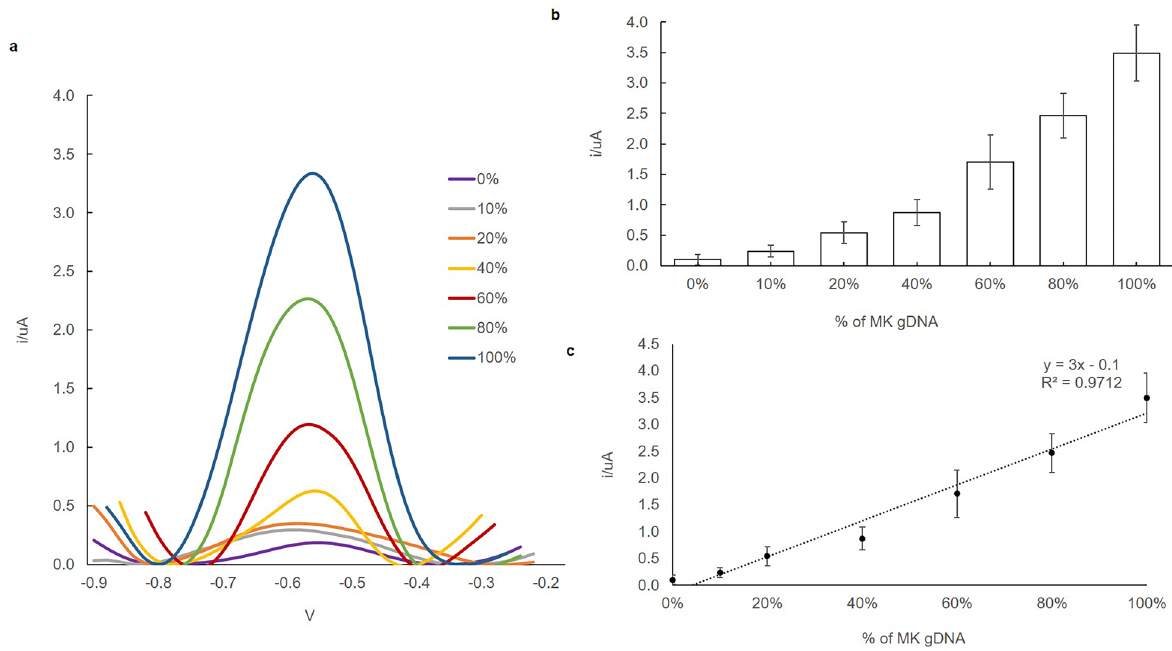
Figure 4. Differential pulse voltammograms ( a ) biosensor response trends; ( b ) linear response range and ( c ) of DNA probe/AuNPs/SPE electrode upon hybridisation with different concentration of MK (0%, 10%, 20%, 40%, 60%, 80%, 100%). Hybridization was performed in 0.05 M K-phosphate buffer (pH 7.0) containing 10 mM AQMS. The DPV peak rate was observed at − 0.55 to − 0.45 V/s versus Ag/AgCl reference. Error bars are standard deviations across three repetitive